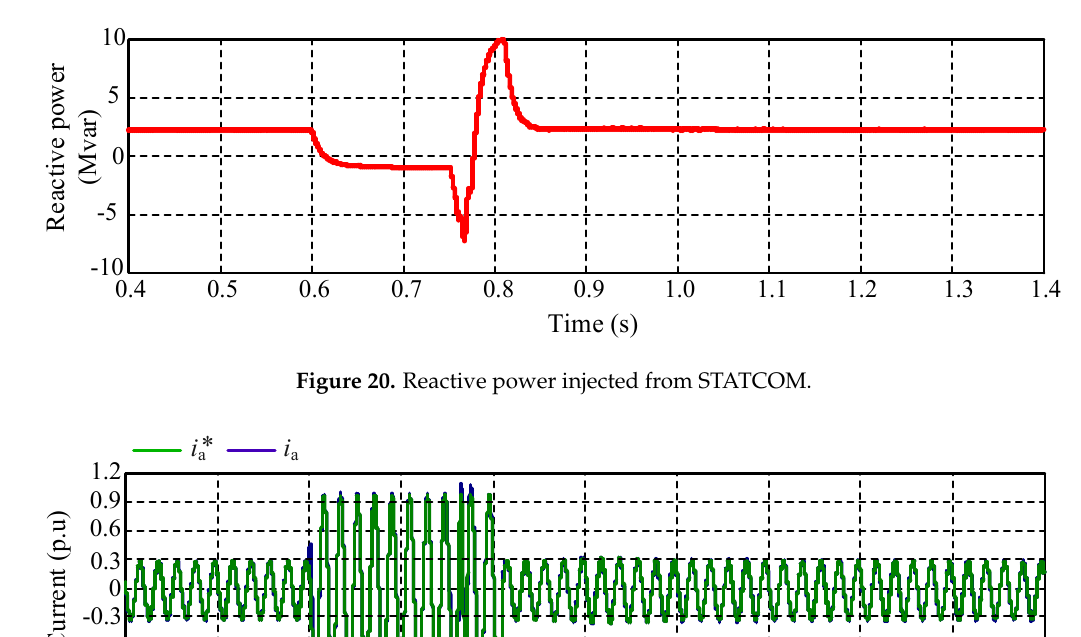
Figure 19. Magnitudes of the voltage at the public network. Energies 2016 , 9 , 302